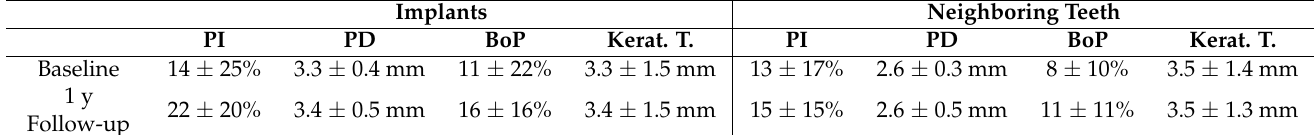
Table 2. Clinical parameters (mean percentage of measured sites with presence of plaque (PI), mean probing depth (PD), mean percentage of measured sites with bleeding on probing (BoP), and mean width of the keratinized mucosa (Kerat. T.)) per implant and neighboring teeth at baseline and at 1-year follow-up.